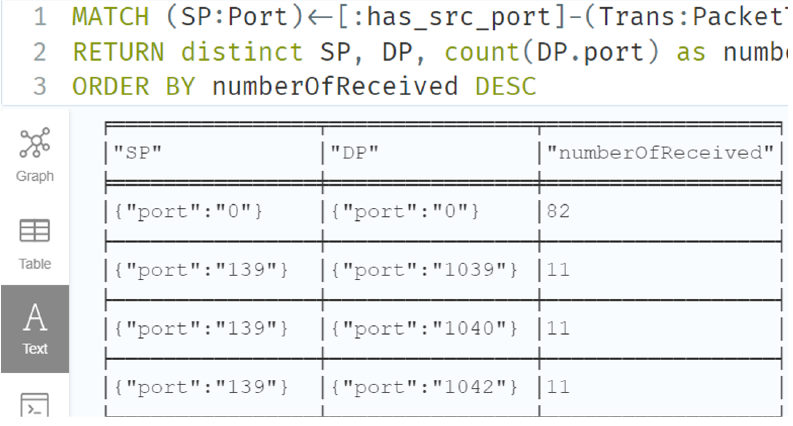
Figure 11. Numbers of communication between the source port and the destination